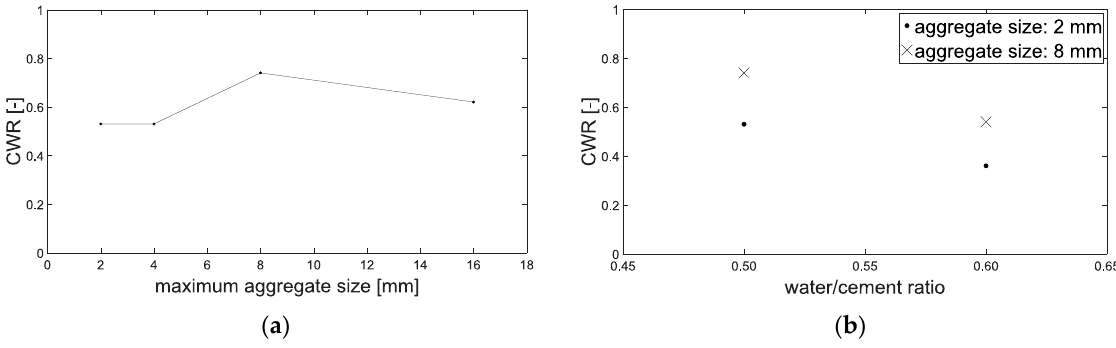
Figure 11. Crack-width ratio CWR in relation to the mean surface-crack width w sur,m .